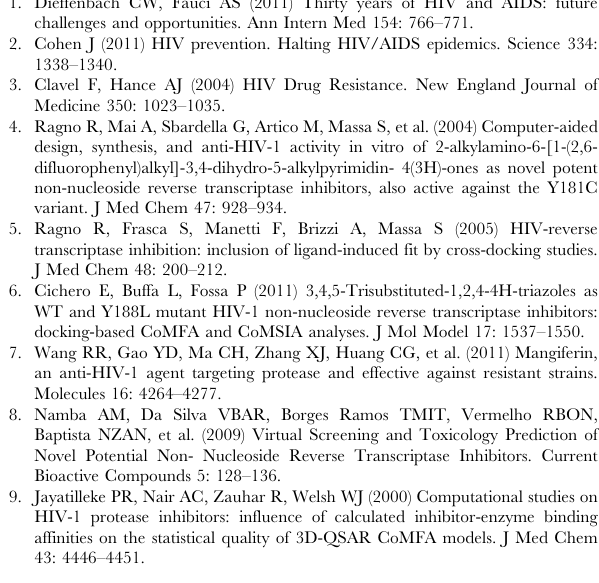
Table S1 Training set used for construction of the proteochemometric models. Table S2 Test set used for assessment of the proteo- chemometric models. Table S3 Removed outliers. Table S4 PLIFs for all the experimental complexes. Table S5 PLIFs for the eight inhibitors against all the